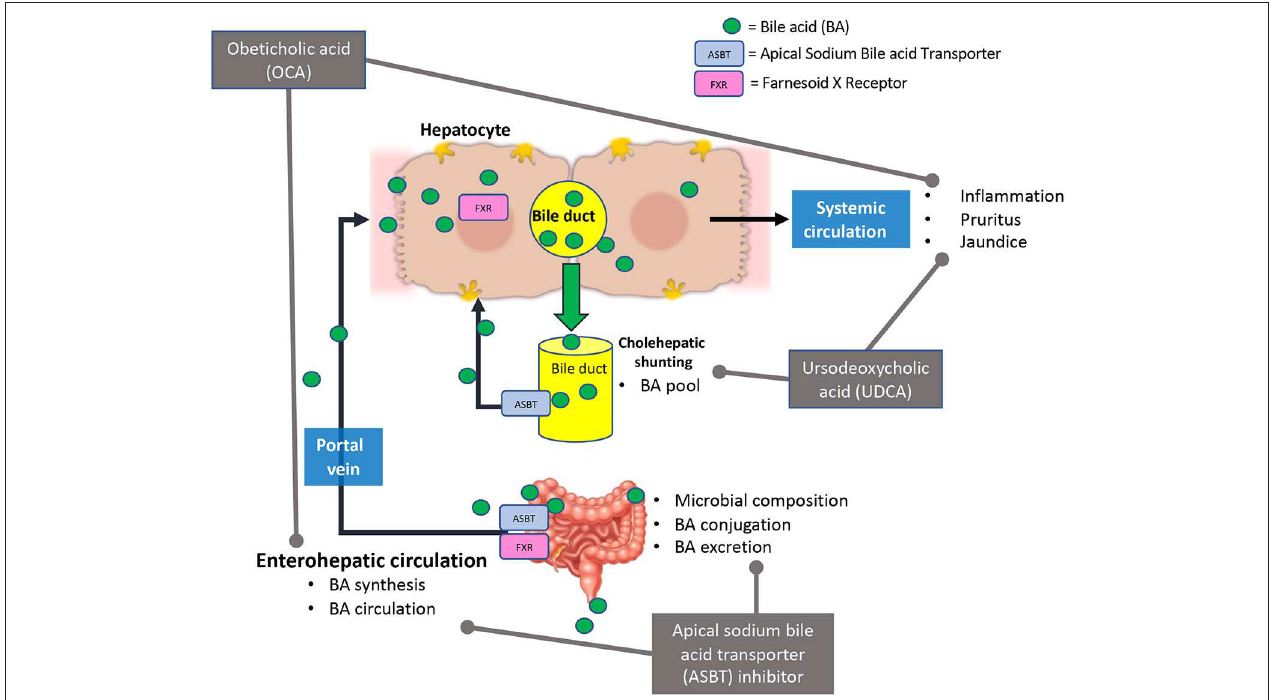
FIGURE 2 | Current bile acid receptor therapeutics and their effects in bile acid signaling. Briefly, Obeticholic acid (OCA) reduces bile acid (BA) synthesis, circulating BA levels, and hepatic inflammation. This treatment may cause adverse effects such as pruritus and jaundice (in decompensated PBC patients). Ursodeoxycholic acid (UDCA) alters BA pool and reduced hepatic inflammation and damage. In some cases, UDCA treatment has led to development of pruritus. Apical sodium bile acid transporter (ASBT) inhibitors affect bile acid synthesis, circulation, secretion, and microbial composition in the intestine.